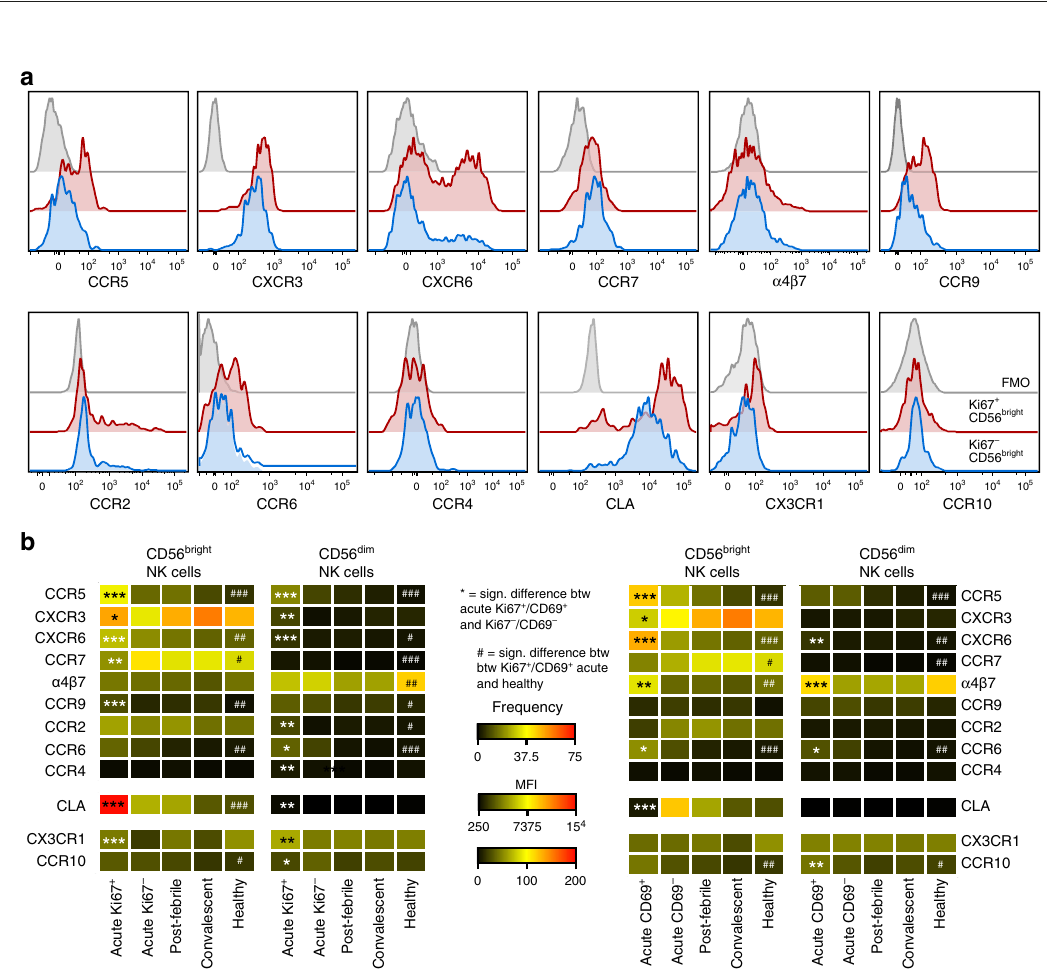
Fig. 6 Assessment of natural killer (NK) cell function during acute dengue virus (DENV) infection. a Representative fl ow cytometry staining shown as concatenated plots for CD107a, interferon- γ (IFN γ ), tumor necrosis factor (TNF), macrophage in fl ammatory protein-1 β (MIP-1 β ), and granulocyte – macrophage colony-stimulating factor (GM-CSF) for CD56 bright and CD56 dim NK cells after the indicated stimulations. Gates were set according to unstimulated cells (no target). Numbers within gates indicate percent positive cells. Rit, Rituximab ® . b Heat map summarizing the frequency of CD56 bright NK cells and CD56 dim NK cells responding to the indicated stimulations (K562 cells, n = 4; 721.221 cells, n = 9; 721.221 cells + Rituximab ® , n = 9; IL-12 + IL-18, n = 4; IL-12 + IL-18 + K562 cells, n = 4) during the acute, post-febrile, and convalescent phase of DENV infection, and healthy controls. c Pie charts showing the number of functions, as de fi ned by Boolean gating, simultaneously exhibited by CD56 bright (left panels) and CD56 dim (right panels) NK cells either at the acute (upper panels) or convalescent phase (lower panels) of DENV infection in response to the indicated stimuli. The number of functions (one to fi ve) is shown in different shades of gray, and the outer arcs indicate which functions were detected within each pie. d Frequency of CD56 bright NK cells and CD56 dim NK cells responding with IFN γ , TNF, and MIP-1 β production upon in vitro infection of healthy donor peripheral blood mononuclear cells (PBMCs) with live DENV (DENV), DENV pre-incubated with the chimeric 4G2 monoclonal antibody (mAb) (DENV + Ab), ultraviolet (UV)-inactivated DENV (DENV UV), UV-inactivated DENV pre-incubated with the chimeric 4G2 mAb (DENV UV + Ab), and with 4G2 antibody only (Ab) for 24 h. Medium control was subtracted. Statistical differences were tested using paired t test or Wilcoxon ’ s matched-pairs signed-rank test. * P < 0.05 and ** p < 0.01; n.s. not signi fi cant. Source data are provided as a Source Data fi le